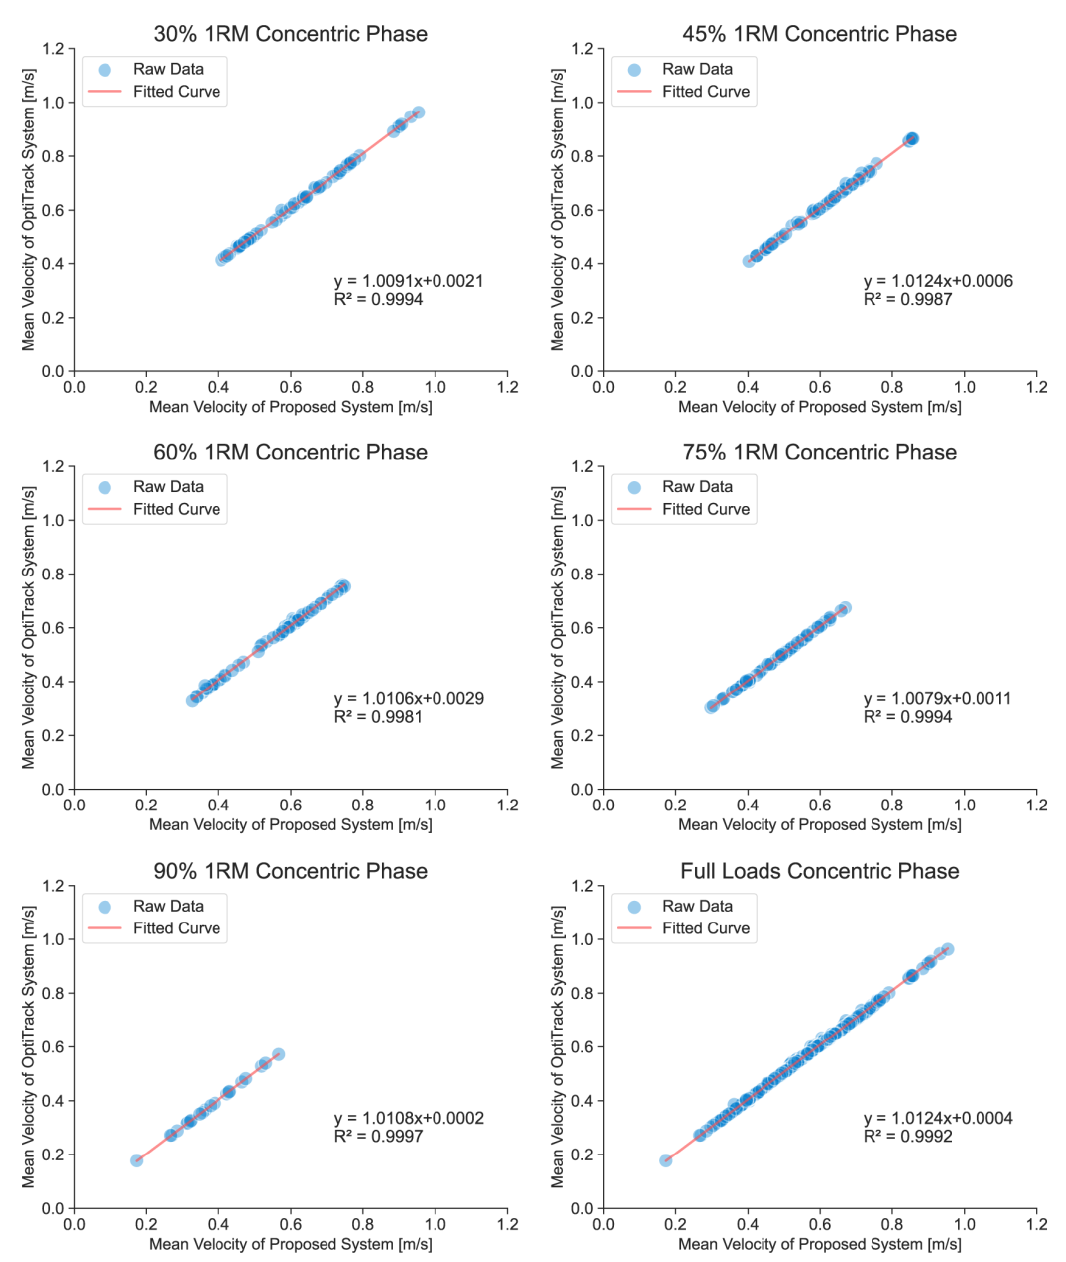
Figure 7. Linear regressions of mean velocities in the concentric phase under different loads, measured by the FRTMS versus the OptiTrack system.